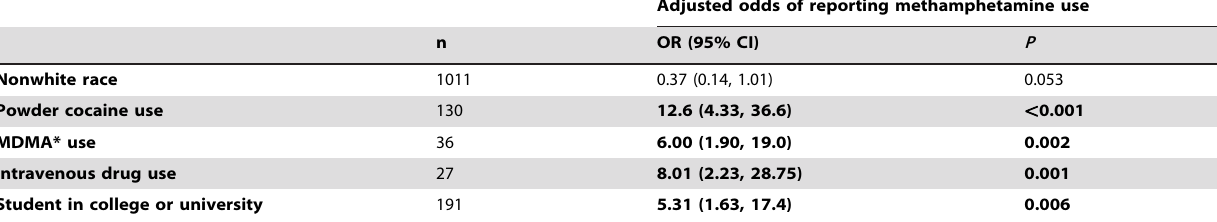
Table 2. Multivariate analyses of factors associated with methamphetamine use among 1,460 men aged 18–30 diagnosed with HIV in North Carolina, 2000 to